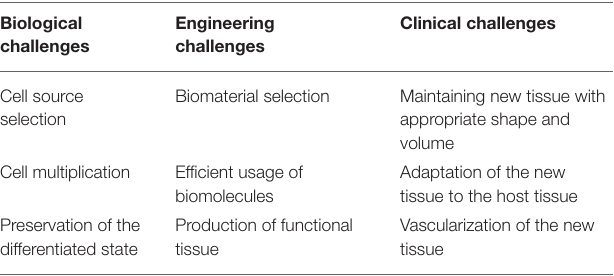
TABLE 1 | Tissue engineering challenges according to in biological, engineering and clinical concerns (Rice et al.,